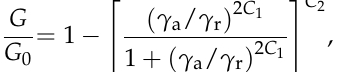
hyperbolic model.